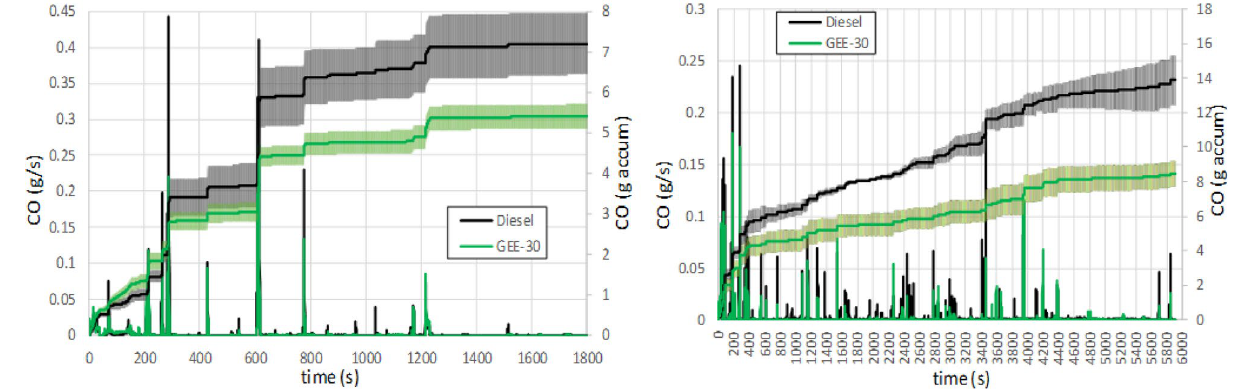
Figure 7. Instantaneous and accumulated CO emissions along WLTC (left) and RDE (right).